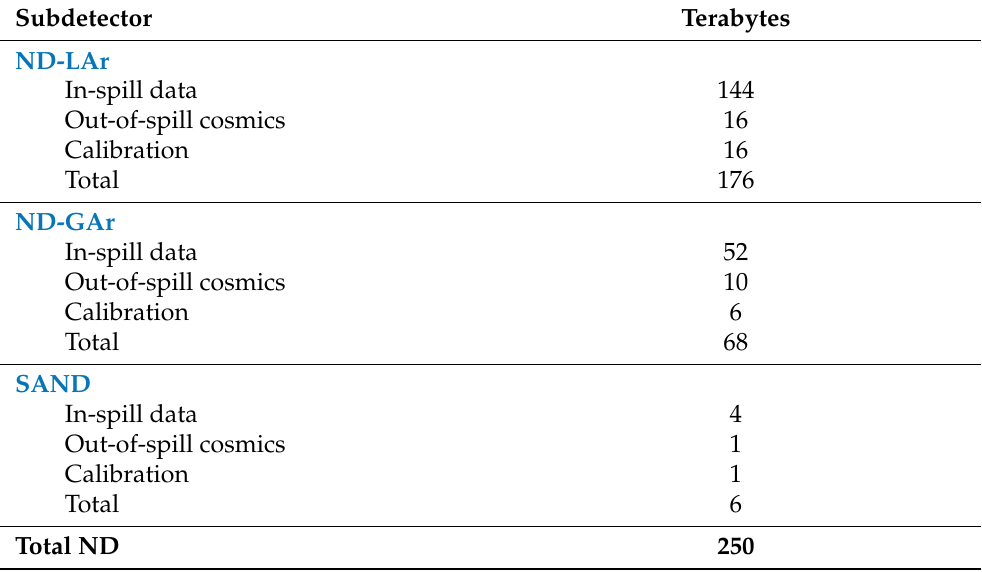
Table 29. Annual DUNE near detector data volume estimates, in Terabytes. No compression is